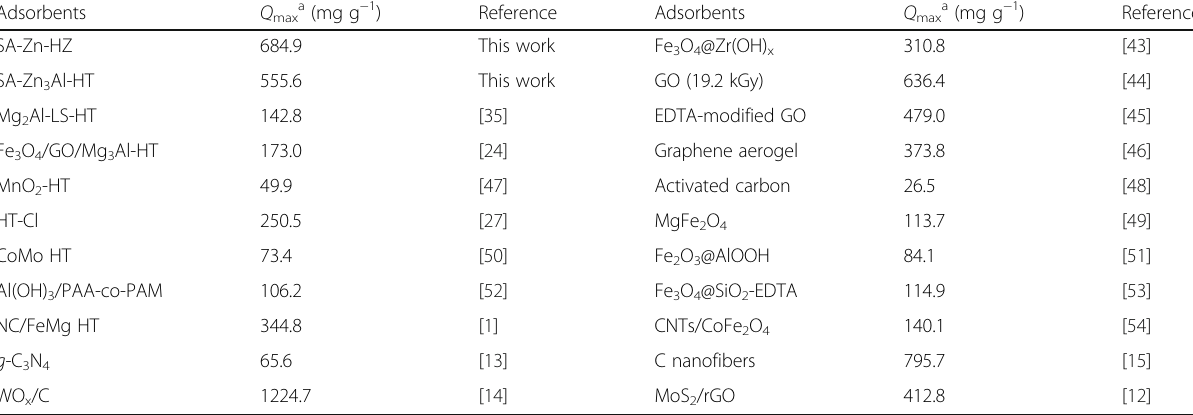
Table 4 Comparison of Pb(II) adsorption capacities of SA-Zn-HZ and SA-Zn 3 Al-HT with other inorganic adsorbents